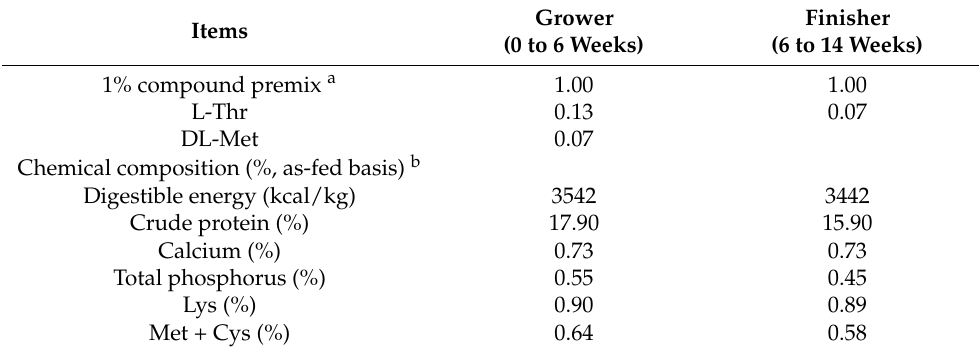
Grower (0 to 6 Weeks)